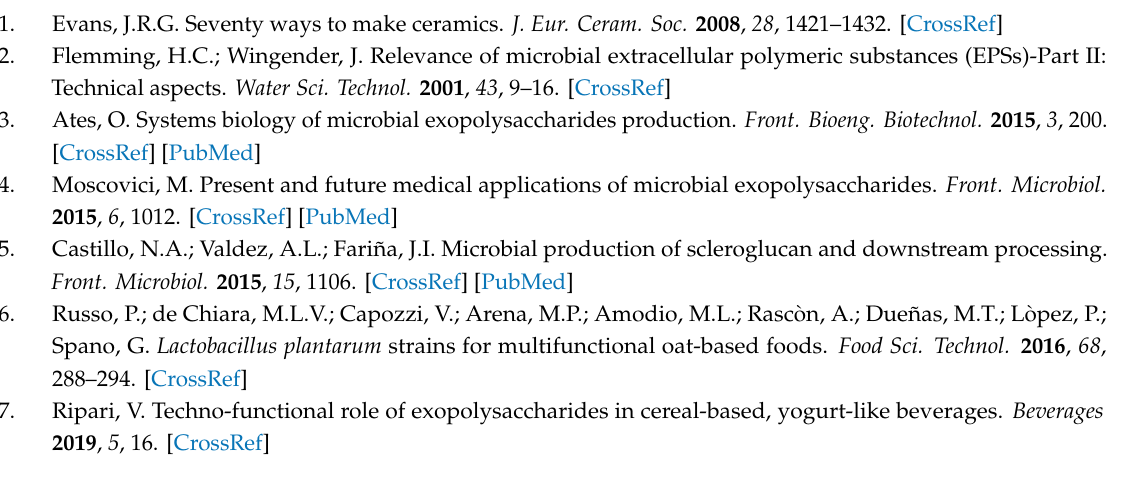
Figure S1: Rarefaction curves, Table S1: Phylogenetic a ffi liations of the 16S rRNA gene sequences of total bacteria obtained from sample 1A (74 sequences, 64 OTUs), Table S2: Phylogenetic a ffi liations of the 16S rRNA gene sequences of total bacteria obtained from sample 2B (69 sequences, 51 OTUs), Table S3: Phylogenetic a ffi liations of the 16S rRNA gene sequences of total bacteria obtained from sample 4D (80 sequences, 54 OTUs), Table S4: Phylogenetic a ffi liations of the 16S rRNA gene sequences of total bacteria obtained from sample 6F (86 sequences, 38 OTUs), Table S5: Phylogenetic a ffi liations of the 16S rRNA gene sequences of total bacteria obtained from sample 7G (79 sequences, 48 OTUs), Table S6: Phylogenetic a ffi liations of the 16S rRNA gene sequences of total bacteria obtained from sample 8H (65 sequences, 38 OTUs), Table S7: Phylogenetic a ffi liations of the OTUs obtained from the ITS fungal sequences of sample 7G–F, Table S8: Phylogenetic a ffi liations of the bacterial strains isolated from samples 1A, 2B, 3C, 4D, 7G and 8H, Table S9: Taxonomy of fungi isolated from samples 1A, 2B, 3C and